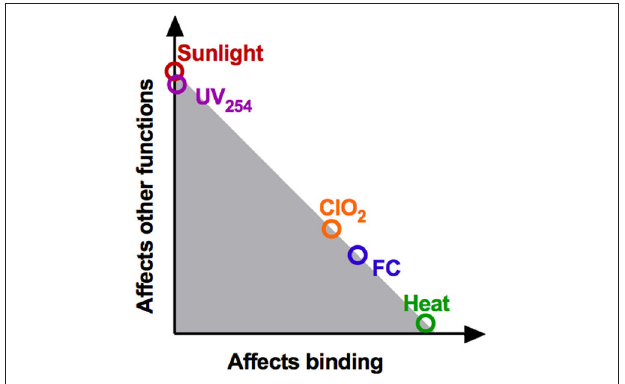
FIGURE 6 | Schematic summary of the contributions of binding loss and other viral functions to overall inactivation. This location of the data points correspond to the ratio of log( N_b/N_b 0 ): log( N/N 0 ) (see Figure 4D ). The shaded region represents the additive effects of loss of binding, genome replication and potentially other